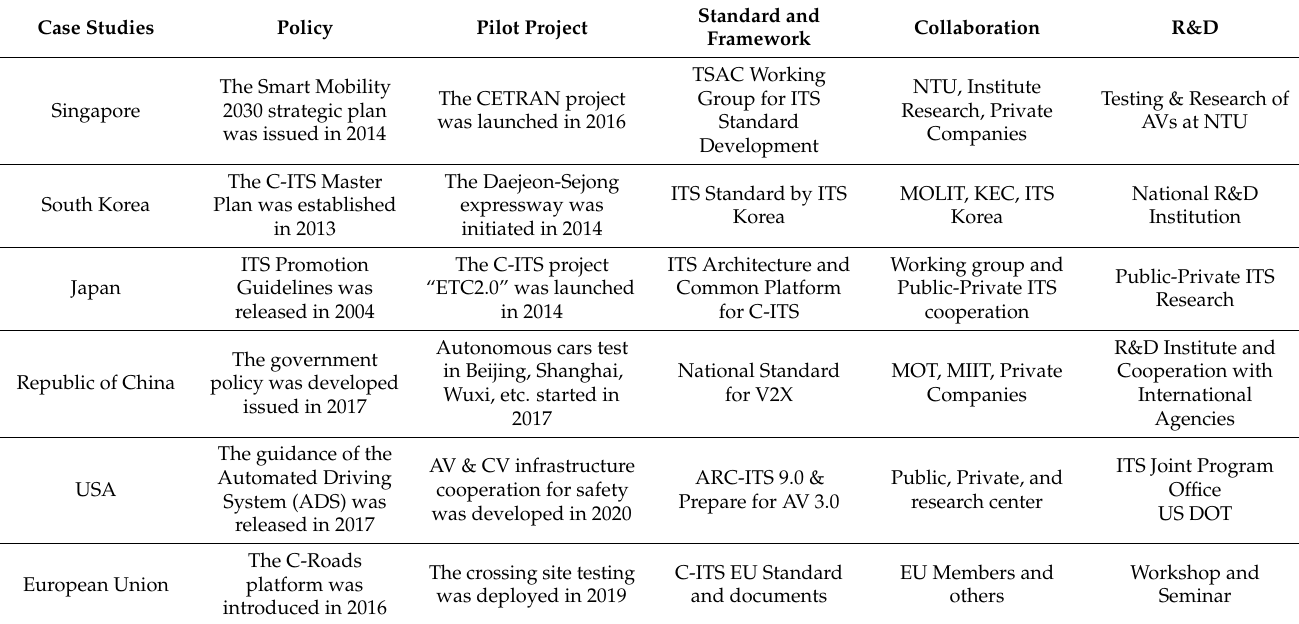
Table 1. Common practice for cooperative-ITS (C-ITS) development in the six-case study.